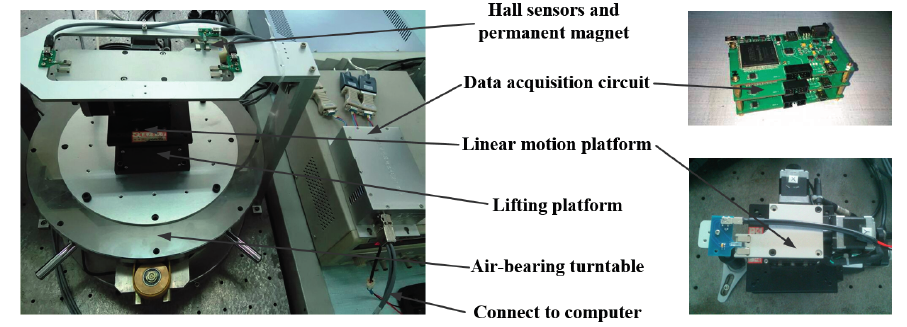
Figure 5. Data collection system with four DOFs.